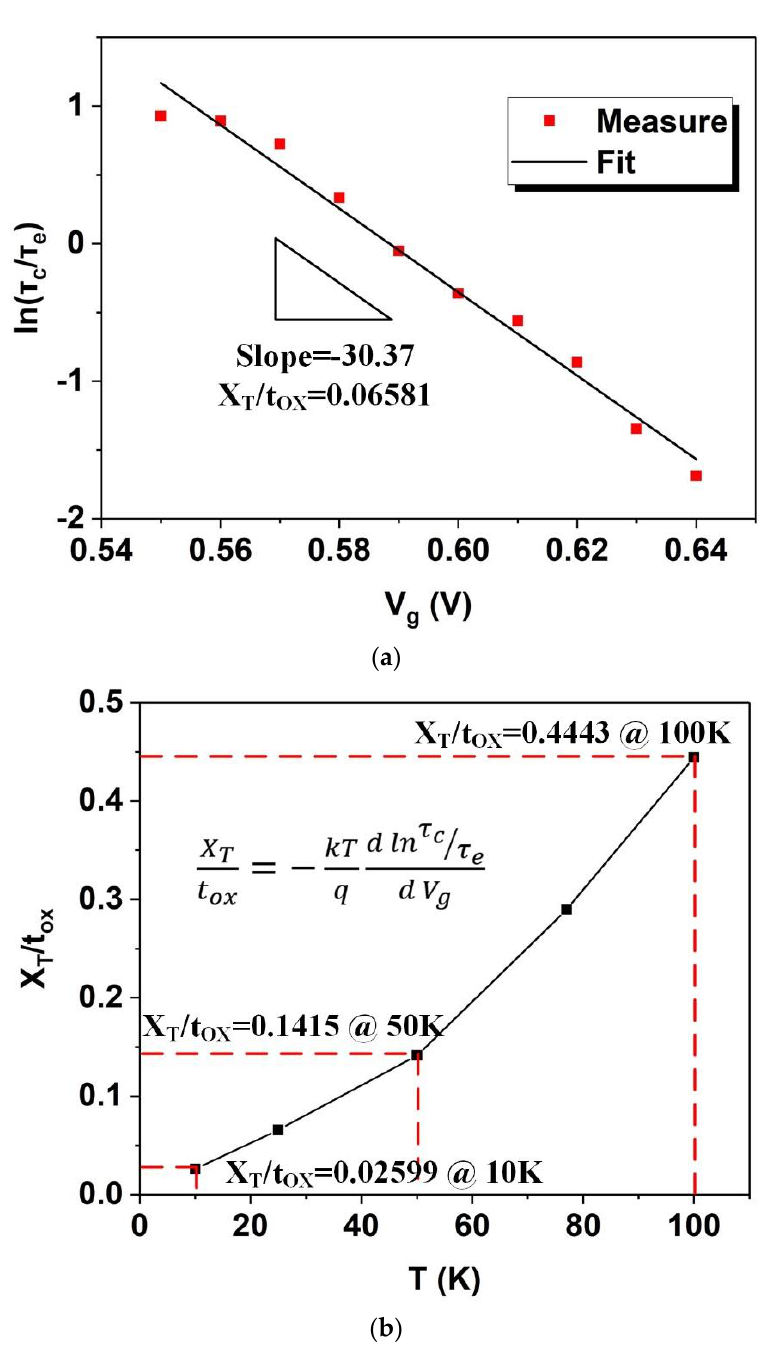
Figure 6. ( a ) Extracting the trap depth at 25 K; the extracted slope is − 30.37, and the calculated X T 0.06581. ( b ) Plot showing the calculated trap depth versus temperature. Table 2. The absolute errors between measured and linearly fitted ln τ c